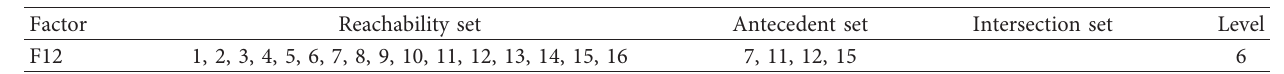
Table 9: Level partitions for level